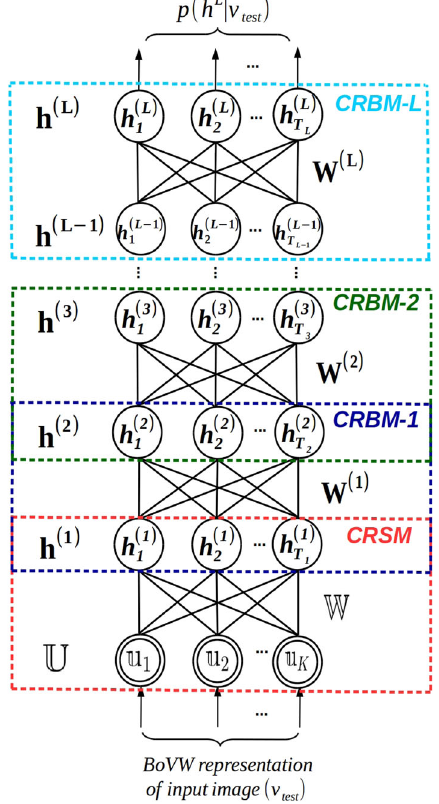
Fig. 7 Graphical representation of the proposed hybrid deep learning